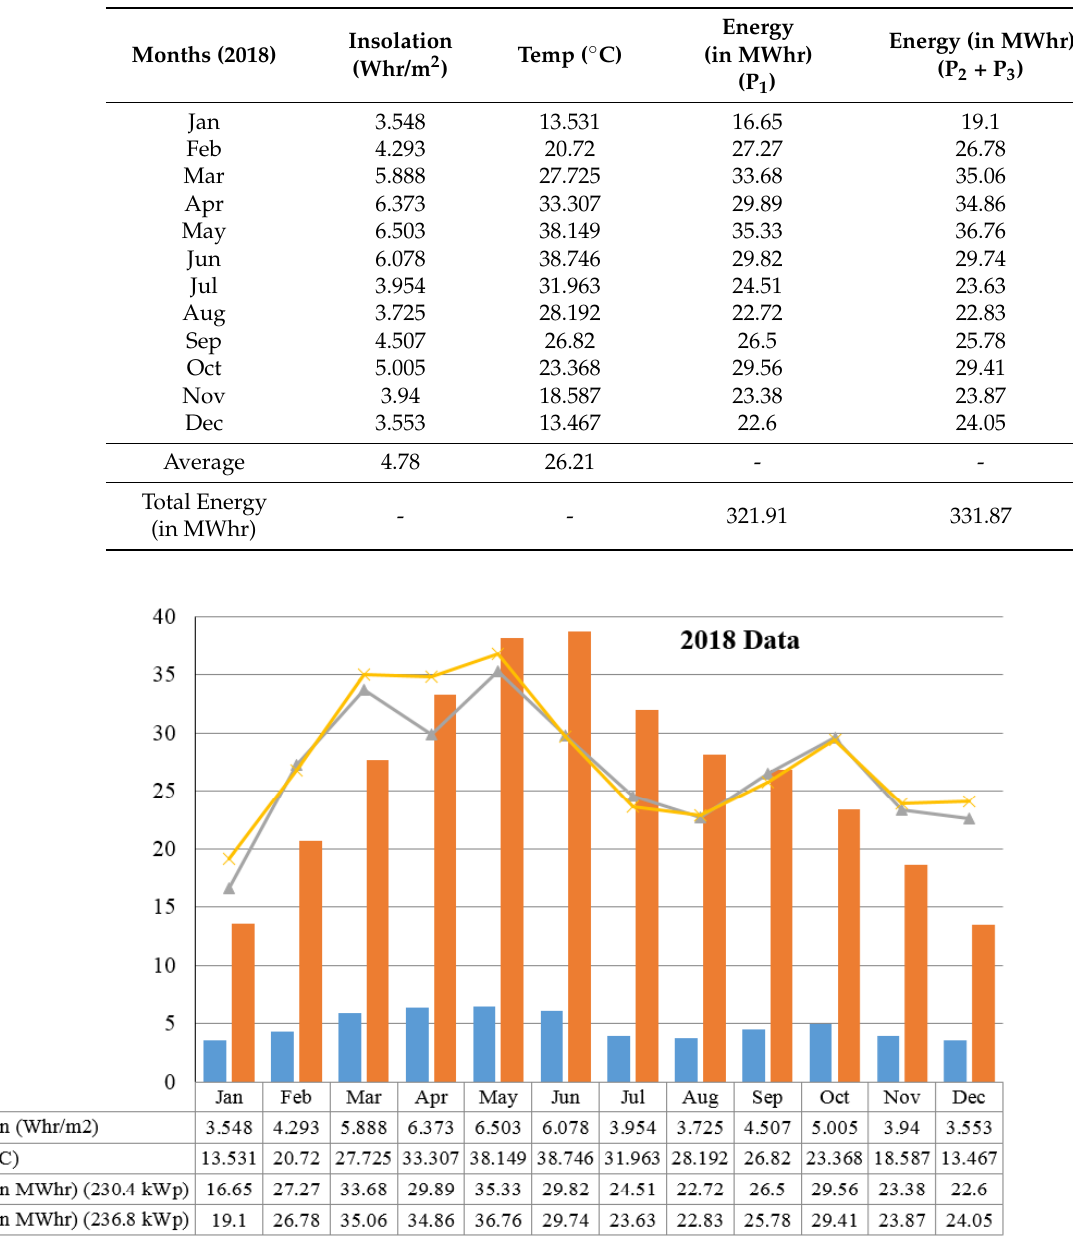
Table 5. Comparison of Generated Energy in 2018 (P 1 vs. P 2 + P 3 ).